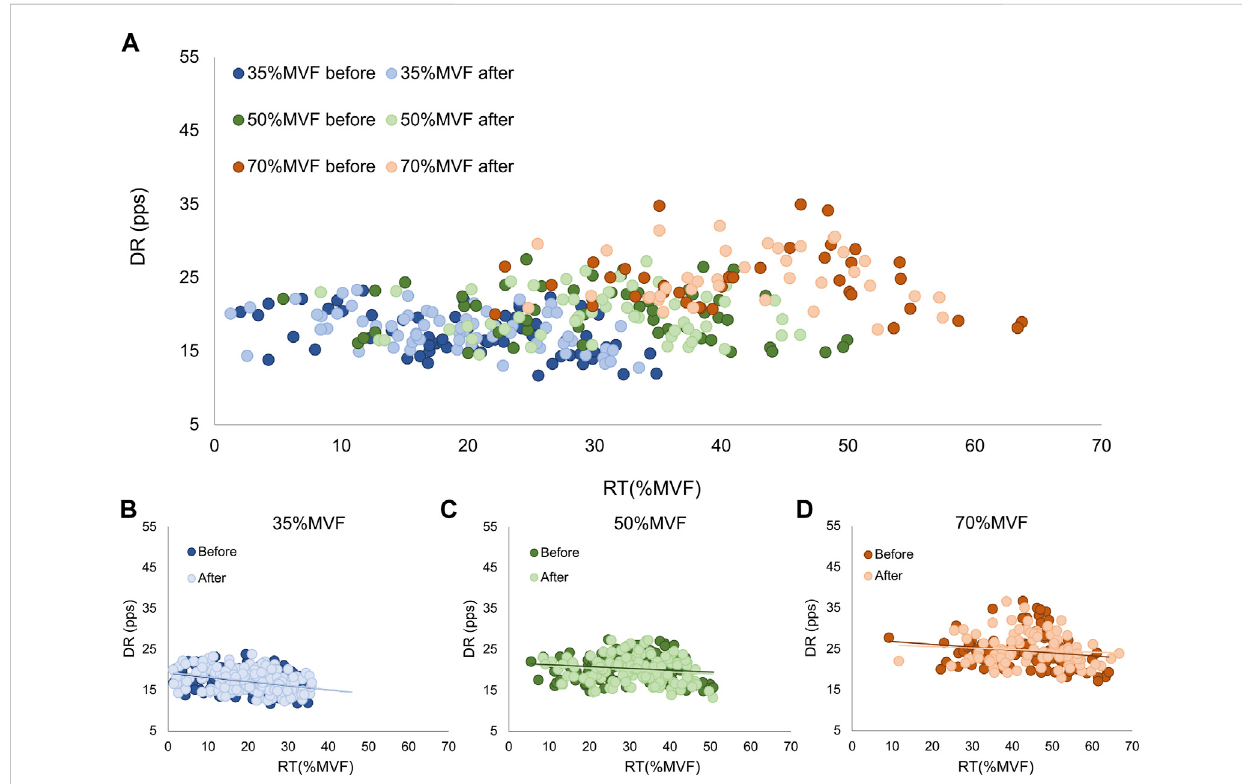
FIGURE 9 Relationship between discharge rate and recruitment threshold of motor units before and after acute WBV exposure. The discharge rate (ordinate) as afunction ofthe recruitment threshold (abscissa) for representing therelationship between these twoparametersas the overall results (A) ,at 35%MVF (B) 50%MVF (C) , and 70%MVF (D) , in WBV